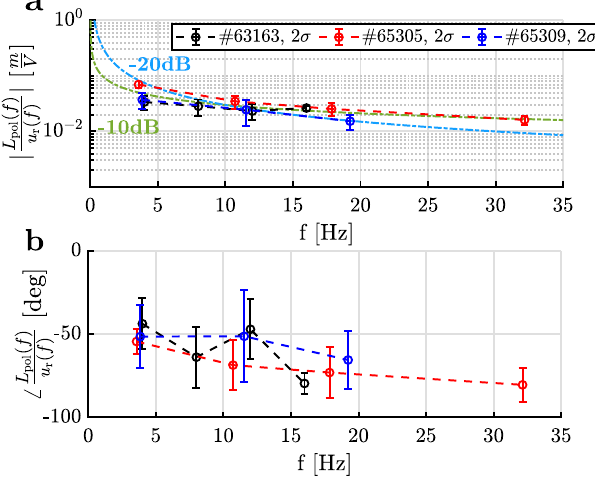
Fig. 6 Overview of estimated frequency responses. Magnitude (plot a ) and phase (plot b ) of the FRFs of all perturbation studies as obtained with the LPM 42 : Unbaf fl ed L-mode # 63163 baf fl ed L-mode # 65305, and baf fl ed H-mode # 65309. The gain of the H-mode experiment is lower and close to the unbaf fl ed L-mode case. The phase characteristic of all FRFs is reminiscent of an irrational transfer function model 44 . 2 σ -Error bars are calculated from the LPM 42